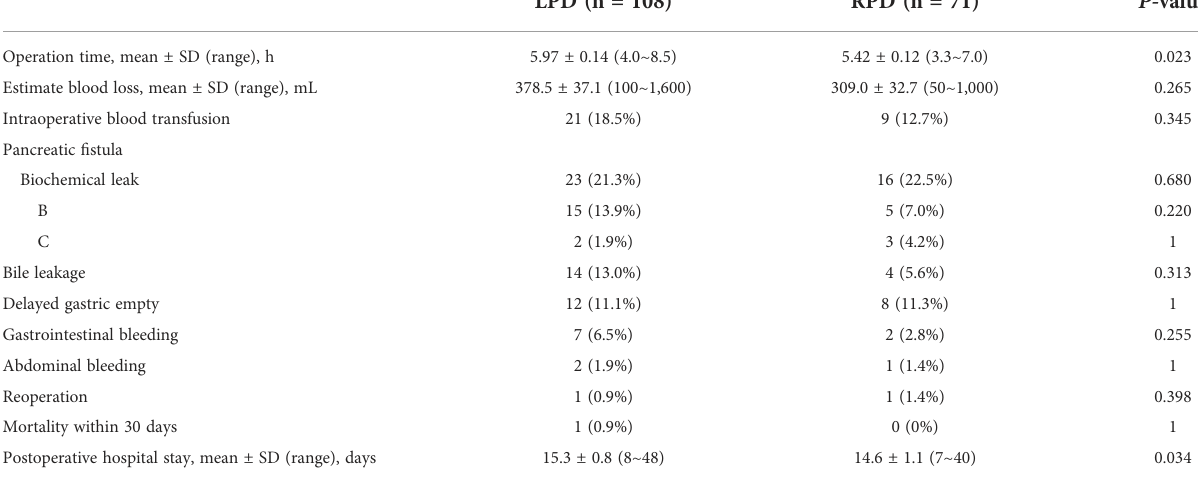
TABLE 2 Perioperative results without